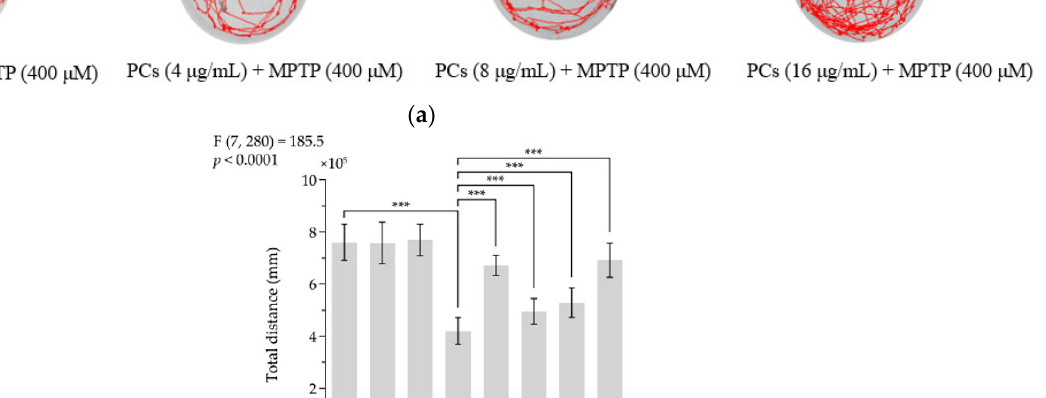
Figure 5. Effects of PCs on zebrafish larvae motility upon MPTP treatment. ( a ) Typical patterns of swimming traces of zebrafish larvae in each group; ( b ) Average total distance of zebrafish larvae in each group. F and p values of the one-way analysis of variance are presented above the chart. The results of Tukey’s post hoc test are presented for selected compar- isons: ***, p < 0.001; the error bars are SD.